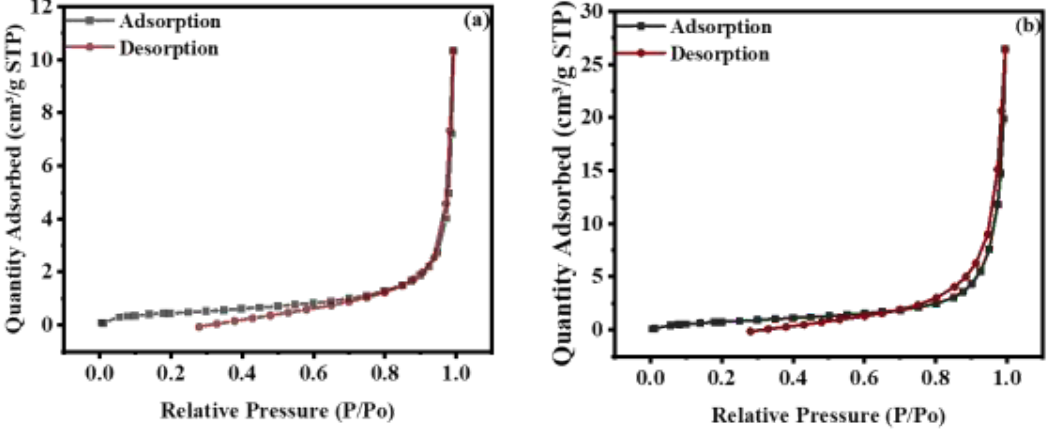
Table 1. Surface properties of WO 3 , WO 3 /MXene nanocomposite calculated from BET analysis.